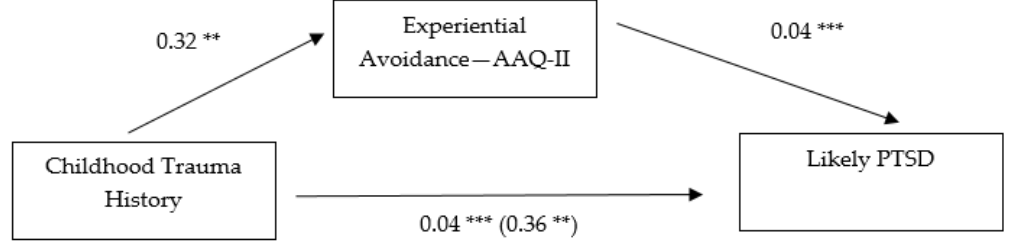
Figure 4. Indirect effect of experiential avoidance (MEAQ) on the relationship between childhood trauma history and a likely PTSD diagnosis. Note. * p < 0.05, ** p < 0.01, *** p < 0.001. Path values were drawn using unstandardized regression coefficients.